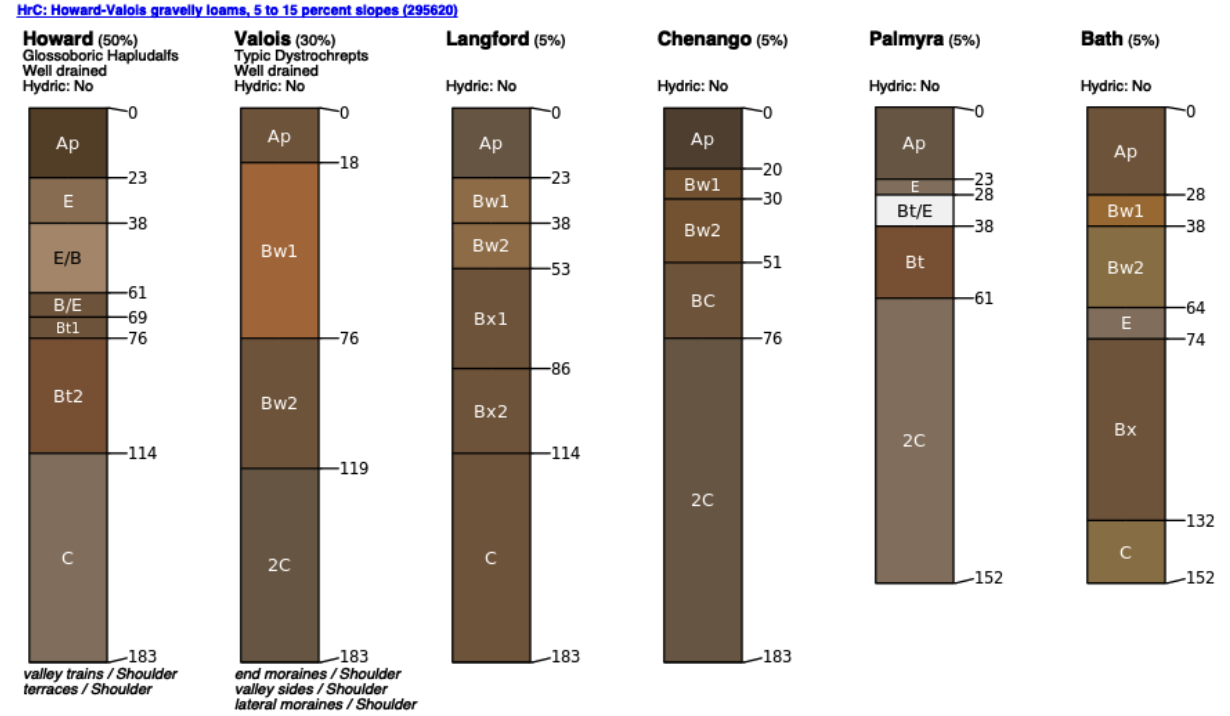
Figure 4. A SSURGO map unit HrC composition at − 76 ◦ 38 (cid:48) 05 (cid:48)(cid:48) E, 42 ◦ 19 (cid:48) 53 (cid:48)(cid:48) N. An interactive map unit summary is available at https: //casoilresource.lawr.ucdavis.edu/soil_web/list_components.php?mukey=295620 (last access: 18 August 2022).